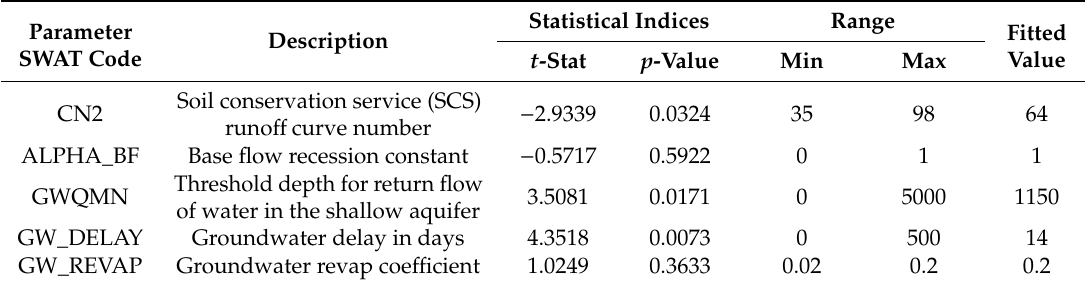
Table 2. SWAT sensitivity analysis and calibration results in the river sub-basin of Lakes Zazari and